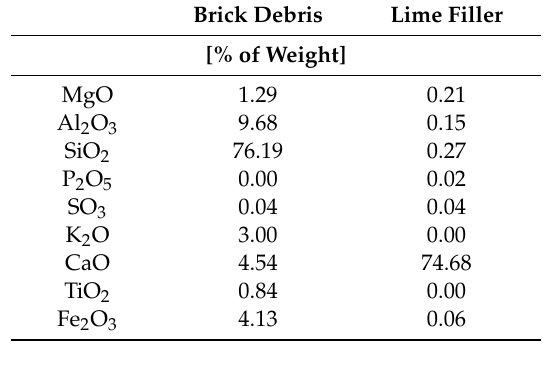
Table 4. Chemical composition of the tested fillers.